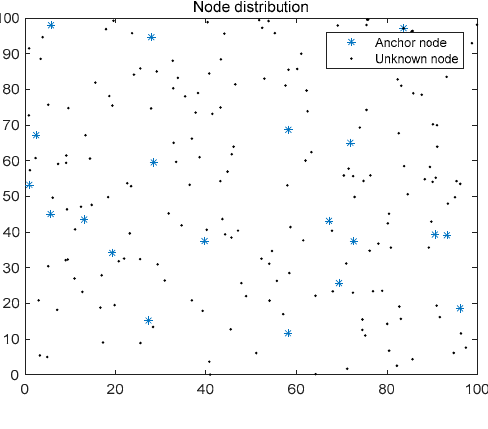
Figure 6. Node Figure 6. Node distribution.